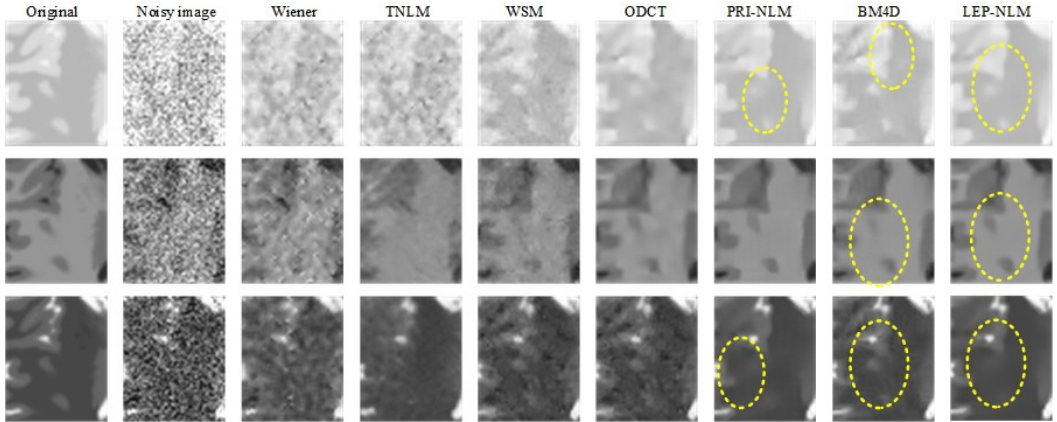
Figure 5. Visual comparison of denoised results for the enlarged ROIs marked with the blue boxes in Figure 4. The top row, middle row, and bottom row are the PD-weighted, T1-weighted, and T2-weighted MR images, respectively.